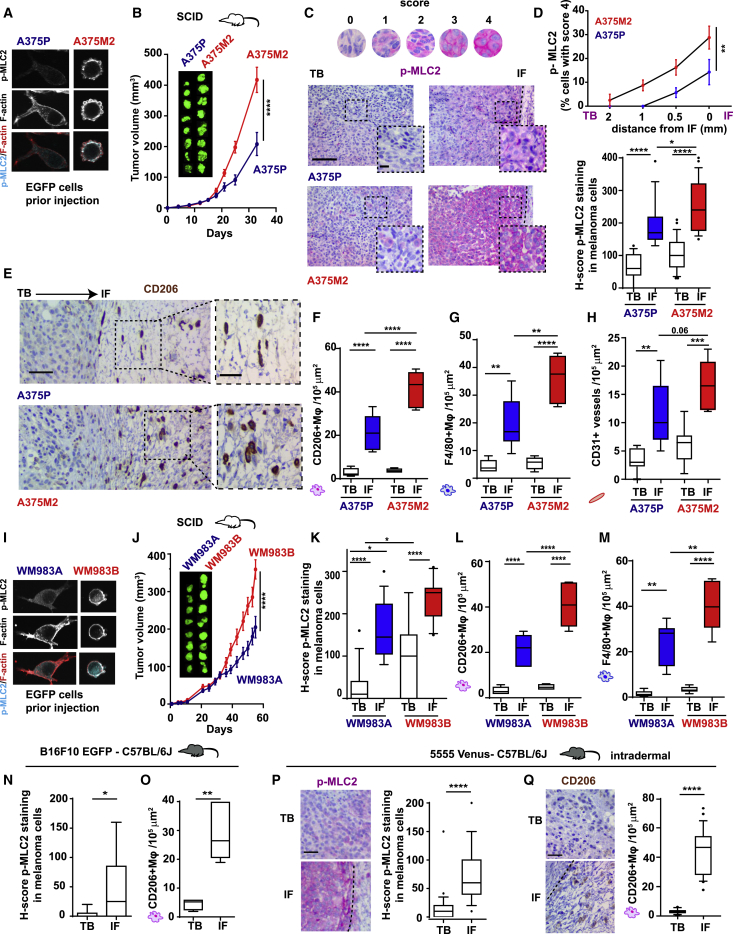
AATME Composition Is a Conserved Feature in Melanoma In Vivo(A) Confocal images for p-MLC2 (cyan) and F-actin (red) in EGFP-A375P and EGFP-A375M2 cells.(B) Tumor volume of xenografts post-injection of EGFP-A375P and EGFP-A375M2 cells (n = 8 mice/group).(C) Immunohistochemistry (IHC) images of p-MLC2 levels (scale bar, 50 μm; insert, 10 μm).(D) (Top) IHC quantification for p-MLC2 levels showing percentage of melanoma cells with the highest score (4) at different distances from IF (0–2 mm) and (bottom) H-score for p-MLC2 staining for A375P and A375M2 tumors (n = 8 mice/group).(E) Representative IHC images of CD206+ macrophages (scale bar, 30 μm and insert: 10 μm).(F–H) Quantification of (F) CD206+, (G) F4/80+, and (H) CD31+ cells in A375P and A375M2 tumors (n = 8 mice/group).(C)–(H) correspond to TB and IF of A375P and A375M2 xenografts, as tested by IHC (n = 8 mice/group).(I) Confocal images for p-MLC2 (cyan) and F-actin (red) in EGFP-WM983A and EGFP-WM983B cells.(J) Tumor volume of xenografts over time (35 days) post-injection of EGFP-WM983A and EGFP-WM983B cells (n = 8 mice/group).(K–M) H-score for p-MLC2 staining (K), quantification of CD206+ (L), and F4/80+ macrophages (M) in TB and IF of WM983A and WM983B xenografts, as tested by IHC (n = 8 mice/group).(N and O) H-score for p-MLC2 (N) and quantification (O) of CD206+ macrophages in TB and IF of B16F10 tumors, as tested by IHC (n = 8 mice).(P and Q) (Left) IHC images and (right) H-score for p-MLC2 staining (P), (left) IHC images and (right) quantification of CD206+macrophages (Q) in TB and IF of 5555 tumors (n = 5 tumors). Scale bar, 30 μm.In (B), (D, top), and (J), graphs show mean ± SEM. In (D, bottom), (F)–(H), and (K)–(Q), boxplots show 10–90 percentile. In (B), (D, top), and (J), two-way ANOVA with Bonferroni post hoc test is shown. In (D, bottom), (F)–(H), and (K)–(M), one-way ANOVA with Tukey post hoc test is shown. In (N)–(Q), t test is shown. Nonsignificant p > 0.05, ∗p < 0.05∗∗, p < 0.01, ∗∗∗p < 0.001, ∗∗∗∗p < 0.0001.See also Figure S4.